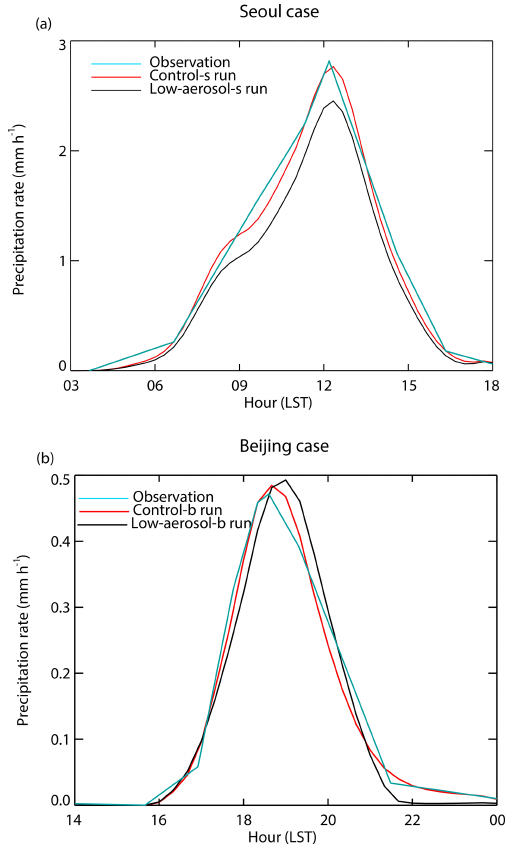
Figure 3. Time series of precipitation rates at the surface, which are averaged over the domain and smoothed over 1h, (a) for the control-s and low-aerosol-s runs in the Seoul area and (b) for the control-b and low-aerosol-b runs in the Beijing area. In (a) and (b) , the averaged and observed precipitation rates over the observation sites in the Seoul and Beijing areas, respectively, are also shown.